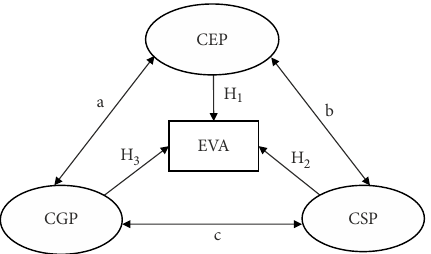
Figure 1. Theoretical model of the structure of the relationships between ESG performance and